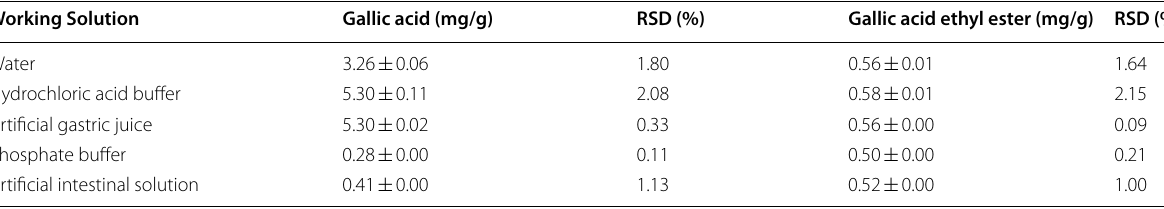
Data are expressed as mean